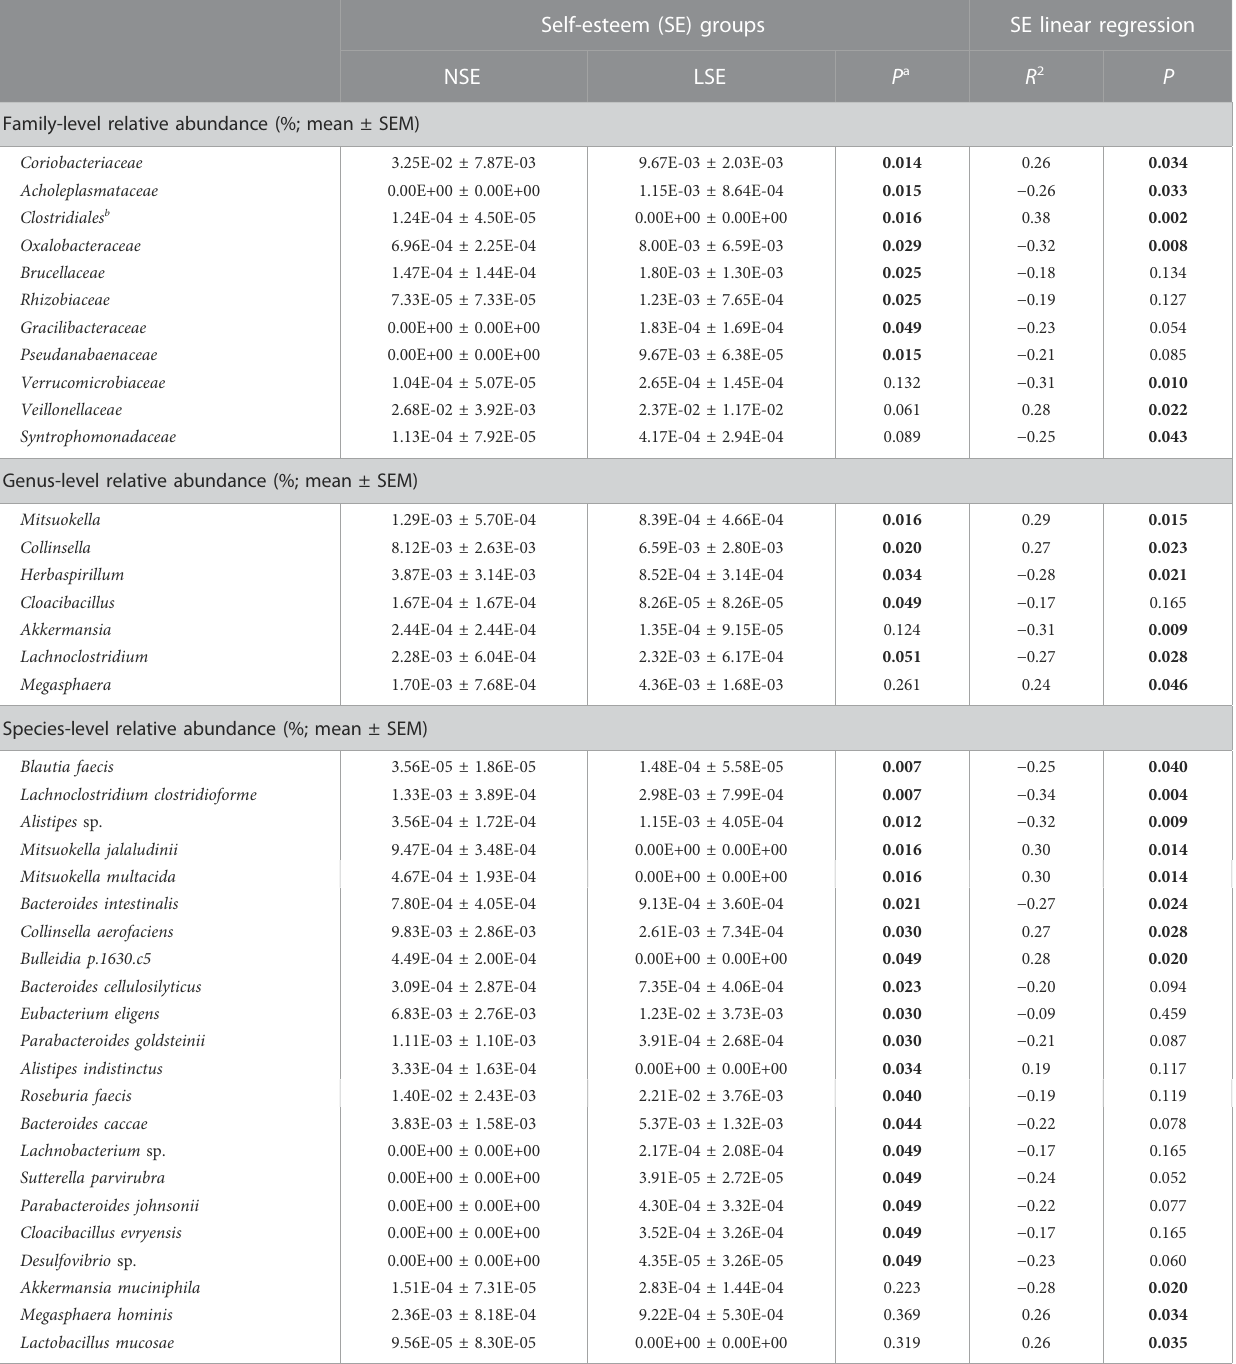
TABLE 3 Intergroup comparisons and linear regression analyses for the mean relative abundance of identi fi ed gut bacterial taxa at the family, genus, and species levels with respect to SE. Self-esteem (SE)